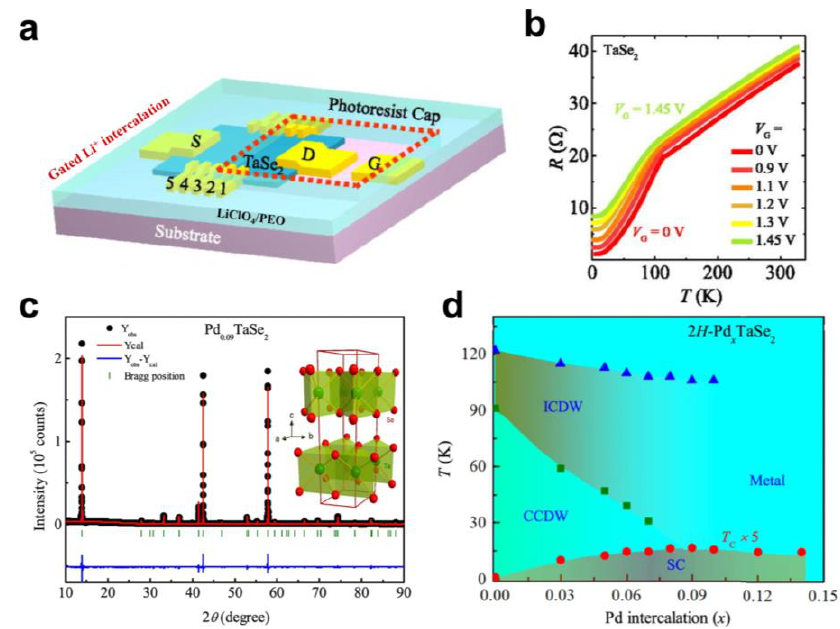
Figure 4. ( a ) Schematic diagram of the gated lithium ion intercalation device for a specific region of 2H-TaSe 2 . Reproduced with permission from Ref. [45]. Copyright 2018, AIP Publishing (Binghamton, NY, USA). ( b ) Temperature dependence of the resistance of TaSe 2 at different V g . Reproduced with permission from Ref. [45]. Copyright 2018, AIP Publishing. ( c ) The PXRD pattern of Pd 0.09 TaSe 2 shows the 2H phase structure that remains after the intercalation, and the inset is a schematic diagram of the 2H-TaSe 2 crystal structure. Reproduced with permission from Ref. [49]. Copyright 2016, Springer Nature. ( d ) The temperature–Pb content phase diagram of the intercalated TaSe 2 . Reproduced with permission from Ref. [49]. Copyright 2016, Springer Nature.